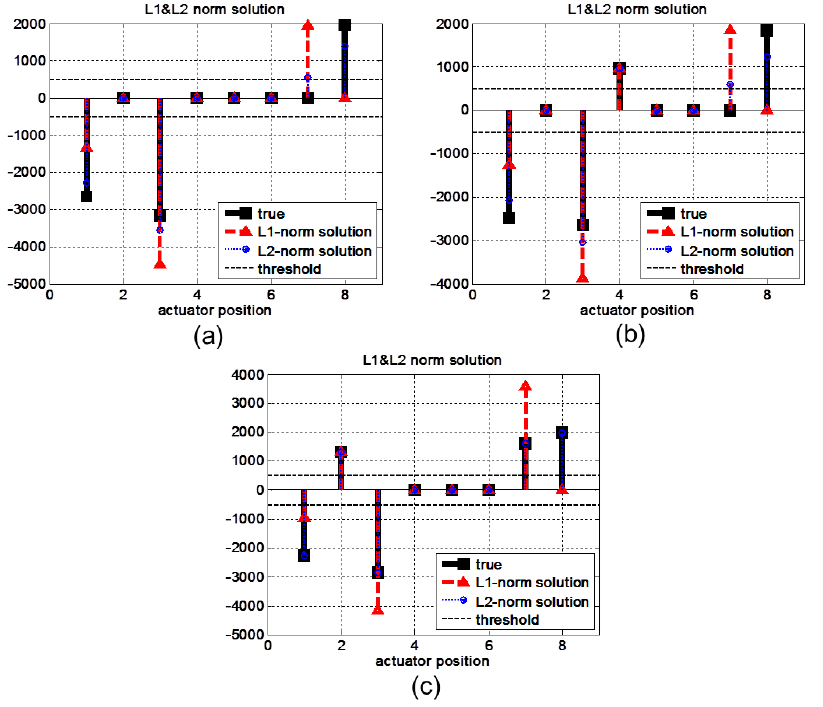
Figure 11. Isolation results obtained by the (cid:96) 1 -norm and (cid:96) 2 -norm minimization methods in cases with three or more simultaneous faults. Because sparsity cannot be guaranteed, the (cid:96) 1 -norm solutions cannot exactly isolate faults. ( a ) Three, ( b ) four, and ( c ) five